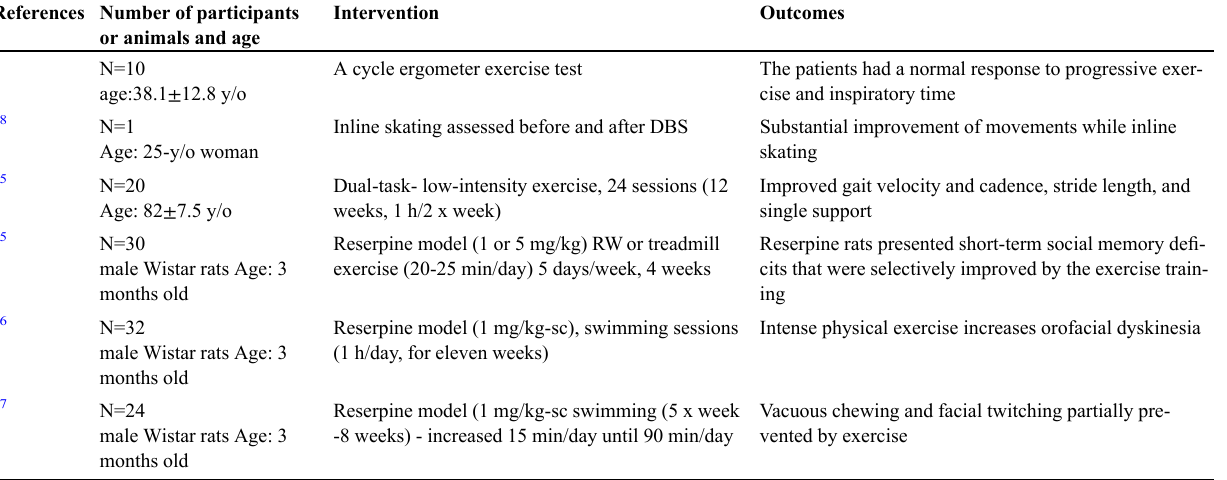
Table 2 - Characteristics of the original articles, selected in the bibliographic search, address the theme of TD and physical activity or exercise from 1994 to 2017. References Number of participants or animals and